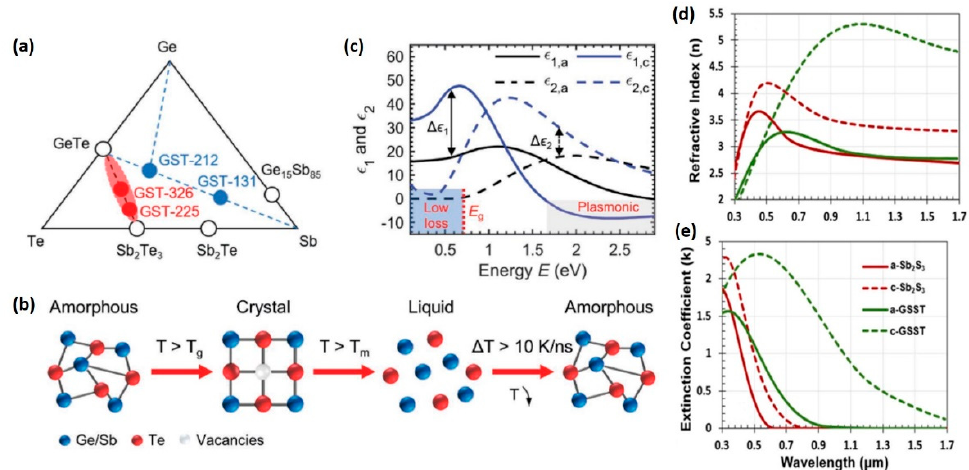
Figure 1. Chalcogenide phase change materials. ( a ) Ternary phase diagram of Ge–Sb–Te showing important pseudo-binary combination. Most frequently used (GeTe) x –(Sb 2 Te 3 ) 1-x compounds such as GST-326 and GST-225 are labeled in red. ( b ) The typical structural transformation in GST-225 when it undergoes a phase transition from amorphous to crystalline to liquid and then back to amorphous. T g and T m are the glass transition temperature and melting temperature, respectively. ( c ) Dielectric function of GST-225 in the amorphous and crystalline phase. ( d ) Refractive index (n) and ( e ) extinction coefficient (k) of the amorphous and crystalline state of Sb 2 S 3 and GSST. (( a – c ) reproduced with permission [21]; ( d , e ) reproduced with permission [37]).